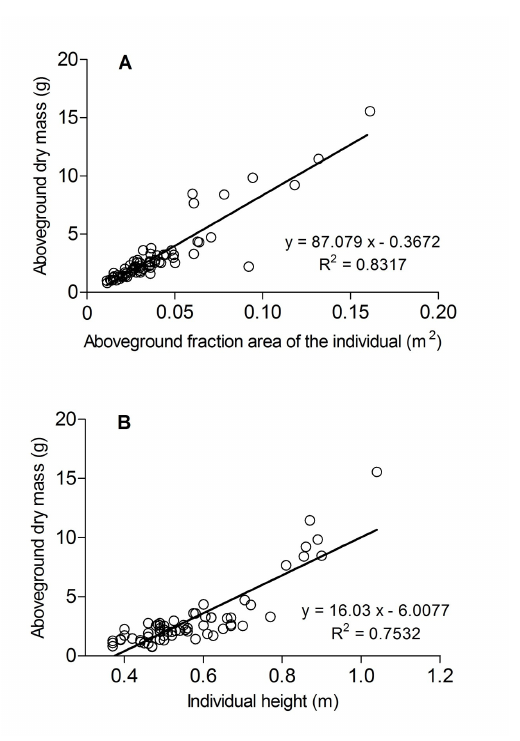
Figure 3. Simple linear regression between the individual aboveground area and aboveground dry mass (A), simple linear regression between the individual height and aboveground dry mass (B) of Crinum americanum , and linear equation and coefficient of determination (R 2